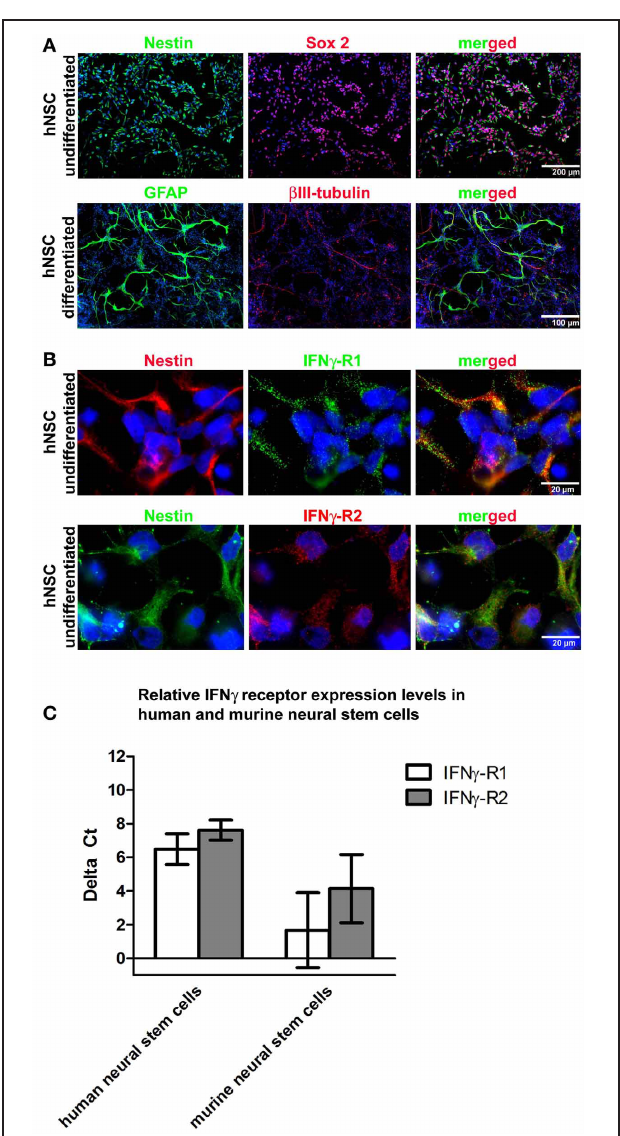
FIGURE 1 | hNSC express IFN γ -RI and IFN γ -RII. In (A) representative photomicrographs of undifferentiated and differentiated hNSCs (Wicell h9 line) are given. To characterize the undifferentiated stage, proliferating cells under the influence of growth factors were seeded and then immediately PFA fixed for immunocytochemistry. To characterize the differentiated stage, cells were seeded and differentiated for four weeks with an initial stepwise reduction of growth factors. In the upper panel immunocytochemical stainings against the neural precursor markers nestin and Sox2 in undifferentiated hNSCs are given demonstrating that the pre-differentiation protocol which starts with pluripotent stem cells yields populations highly enriched in neural precursor cells. In the lower panel immunocytochemical stainings against β III-tubulin and GFAP in differentiated hNSCs are given demonstrating the terminal differentiation of hNSCs into neurons and astrocytes. In (B) representative photomicrographs of undifferentiated hNSCs (Wicell h9 line) are given. A co-immunocytochemical staining against nestin and IFN γ -RI is given in the upper panel and against nestin and IFN γ -RII in the lower panel showing that both IFN γ receptor subunits are expressed in undifferentiated hNSCs. In (C) gene expression levels of IFN γ -RI and IFN γ -RII in undifferentiated hNSCs (Wicell h9 line) and mNSCs is